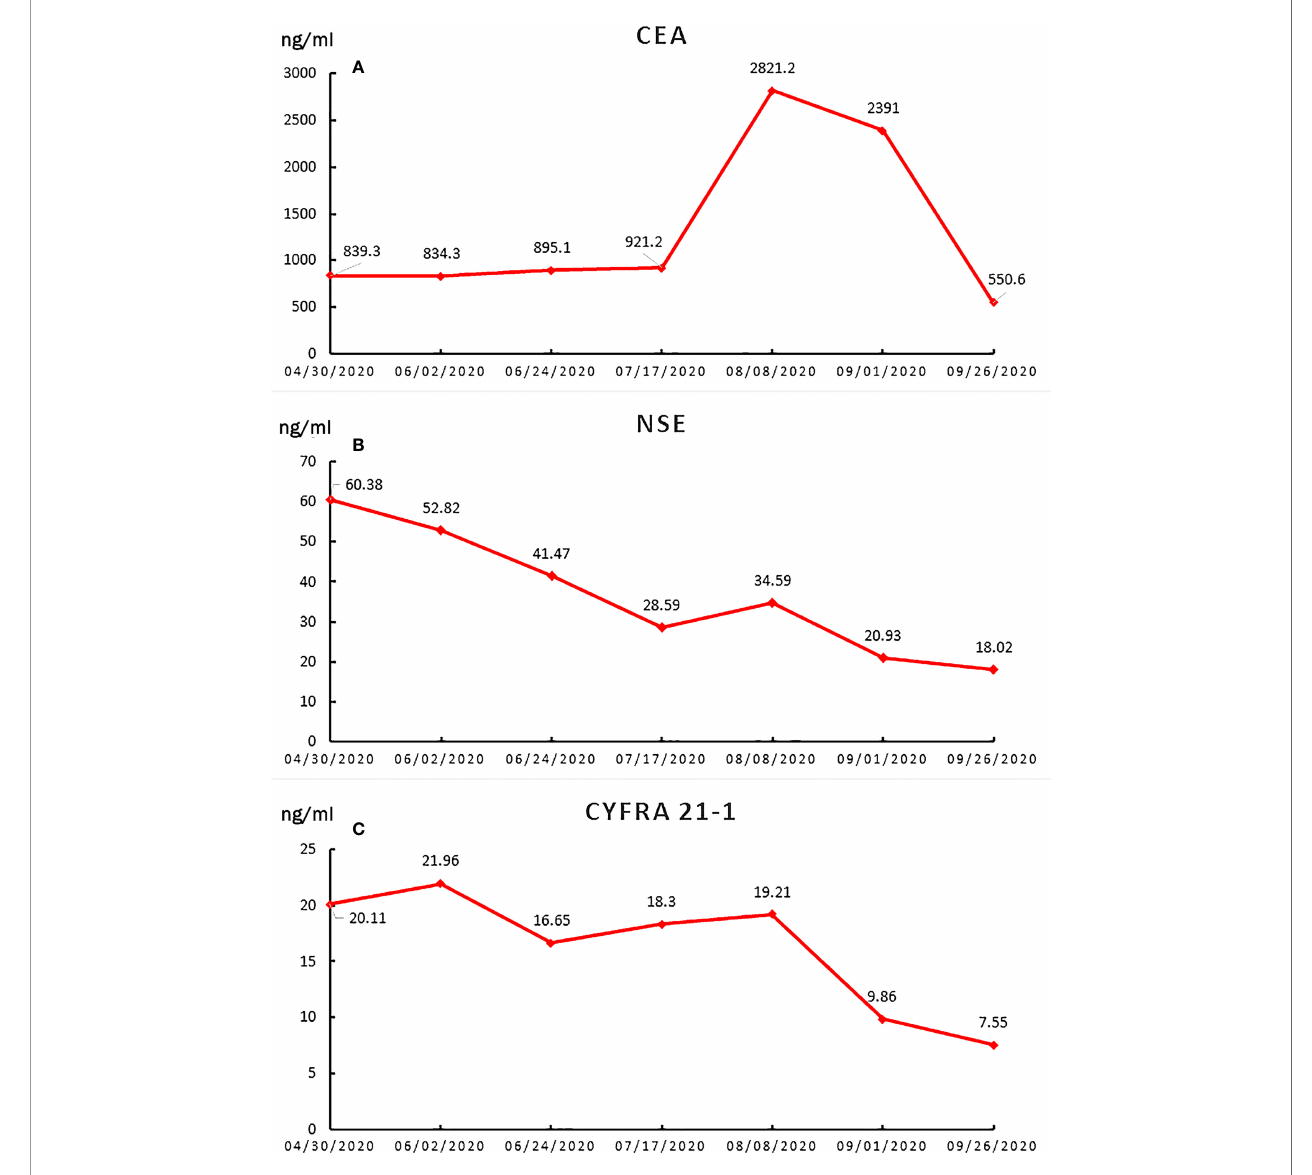
FIGURE 2 | The line charts of tumor biomarkers during the treatment period. (A) CEA; (B) NSE; (C)